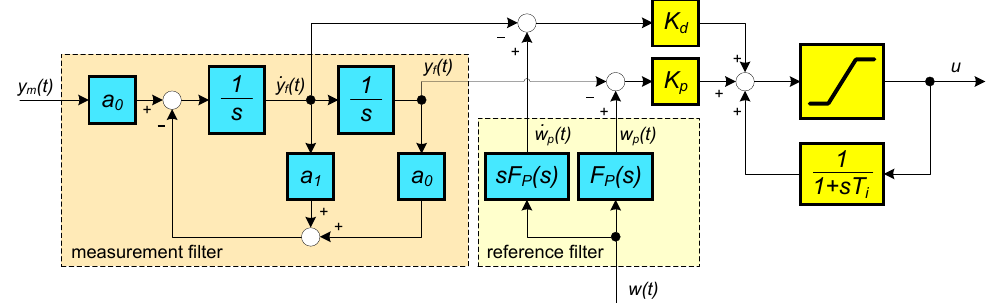
Figure 1. A 2nd-order binomial filter of the measured variable y m ( t ) proceeding an anti-windup implementation of PID controller with proportional and derivative gains K p , K d , with the integral time constant T i , with the reference setpoint w ( t ) and a prefilter F p ( s )